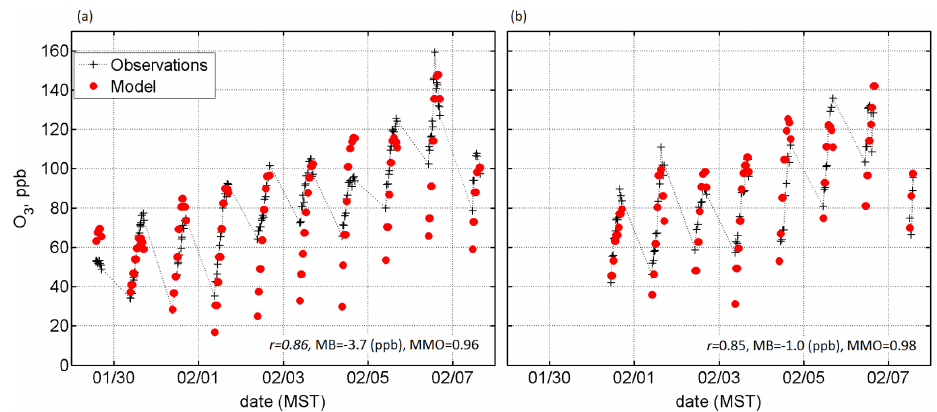
Figure 7. Time series of the daytime (09:00–17:00MST) O 3 mixing ratios measured near the surface by tethersondes and modeled at the (a) Ouray and (b) Fantasy Canyon sites in the winter of 2013. The locations of these tethersonde launchings are shown in Fig. 1. Here, the modeled O 3 values are shown solely for the times when the tethersonde measurements were